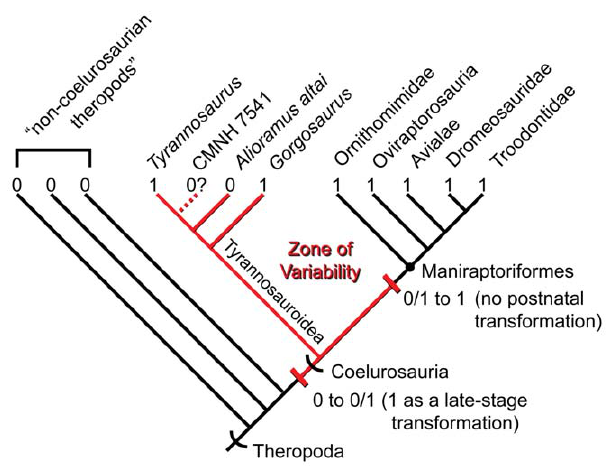
Figure 9. Phylogenetic tree showing the distribution of the plesiomorphic sinus cavernosus (0) in Theropoda. The sinus is invariably present in non-coelurosaurian theropods and invariably lost (1) in non-tyrannosaur coelurosaurs. The secondary loss of the sinus in Alioramus altai and possibly CMNH 7541 is interpreted as reflecting a period in theropod evolution in which the developmental pathways responsible for patterning the diencephalic region exhibited relative high levels of variability. This variability is retained in Tyrannosauroidea and might be expected to characterize at least the early history of its sister taxon. The variability in this case may be driven in part by heterochrony in which the original loss of the sinus occurred as a terminal addition to the ontogenetic sequence and was subsequently eliminated from postnatal ontogeny. Tree topology reflects generally accepted relationships with Theropoda